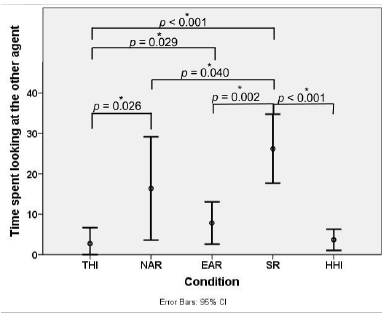
Figure 15: Graph of the Behavioral Data results related to the mean of gaze duration (in seconds) among conditions.